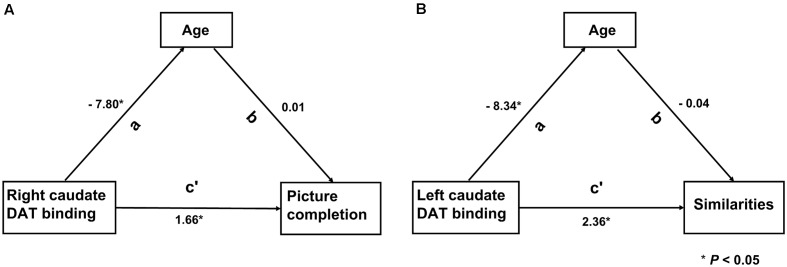
The relationship among the striatal DAT binding, Wechsler Adult Intelligence Scale—third edition (WAIS-III) subscores and age. Two models remarked significantly by path analysis. (A) DAT binding value of right caudate was directly associated with the WAIS-III subscores of picture completion (c’). (B) Left caudate was directly associated with the WAIS-III subscores of similarities (c’). The indirect path was significant (a path) in both models. In this model, the direct and indirect relationships between aging, striatal DAT binding and cognition, the standardized path coefficients (β) are listed as a, b and c’, where a and b are part of the indirect path and c’ is the direct path adjusted for the indirect path.